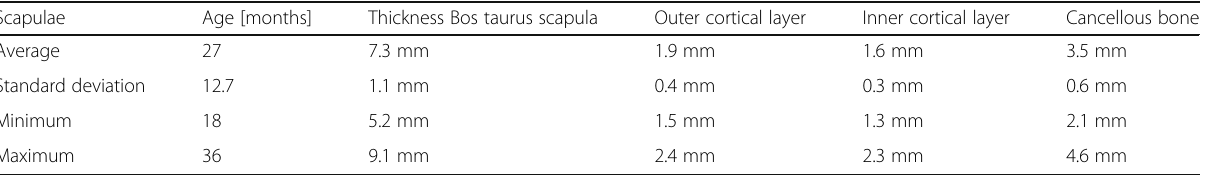
Table 1 Bos Taurus scapulae measurements